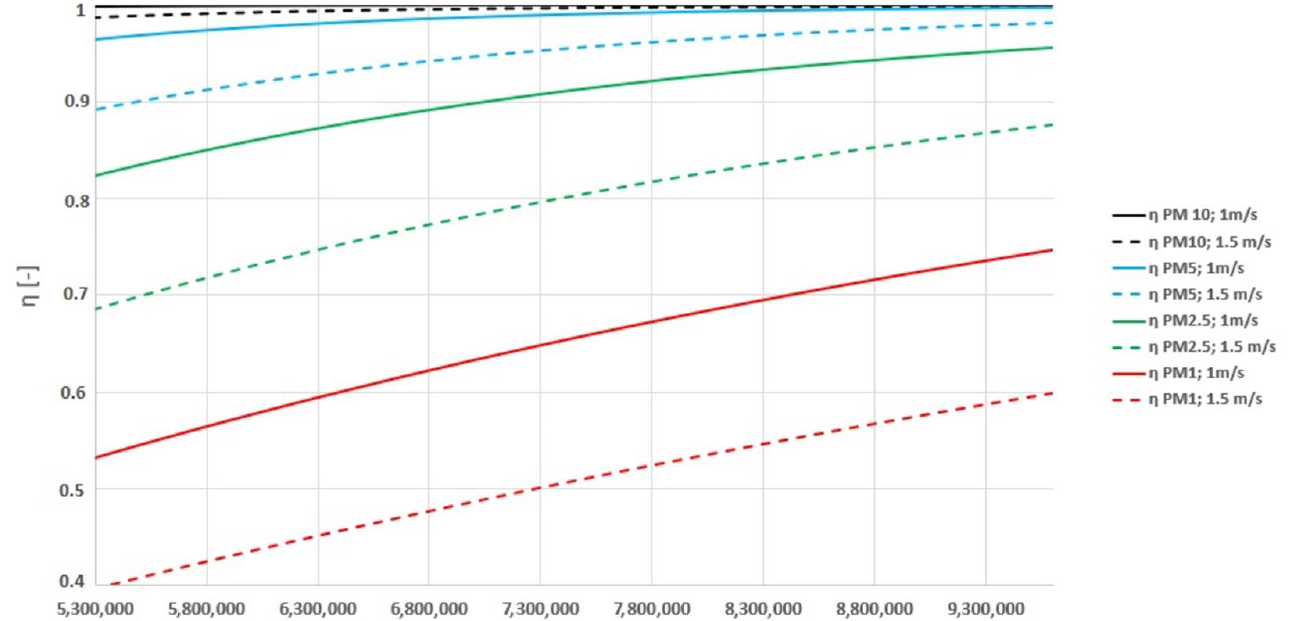
Figure 10. Collecting efficiency for different sizes of particles, depending on electrical field strength and gas velocity.